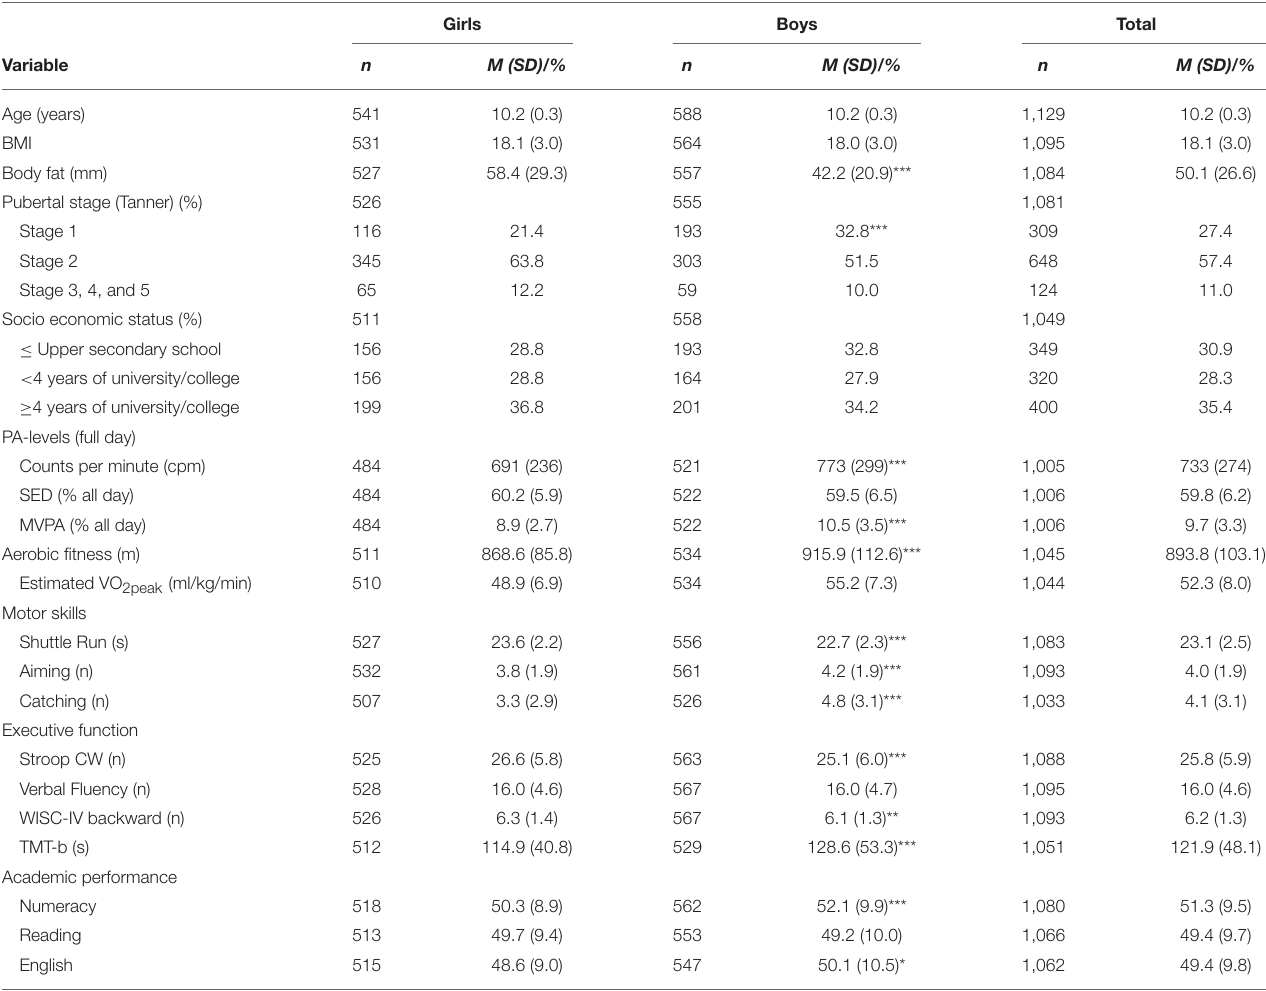
TABLE 1 | Baseline characteristics of the children as means and standard deviations (SD) or frequencies. Girls Boys